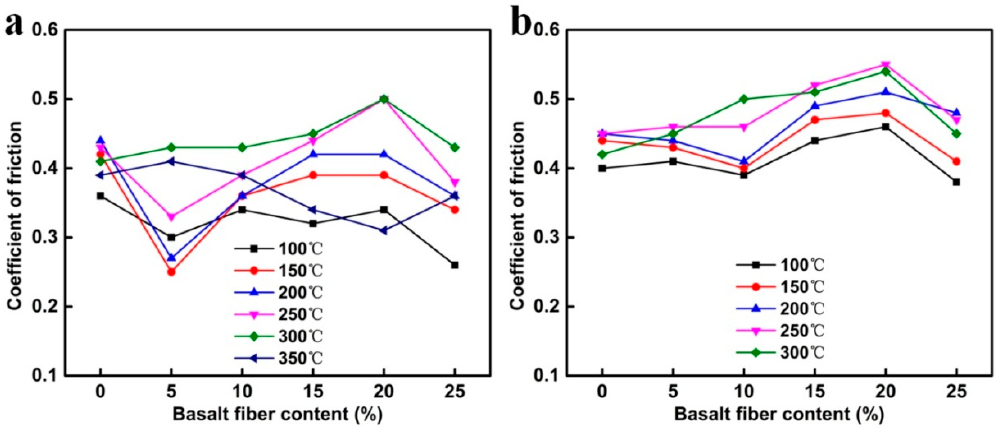
Figure 5. Effects of basalt fiber content on coefficient of friction in ( a ) heating processing and ( b ) Figure 5. E ff ects of basalt fiber content on coe ffi cient of friction in ( a ) heating processing and ( b ) cooling cooling processing at different temperatures. processing at di ff erent